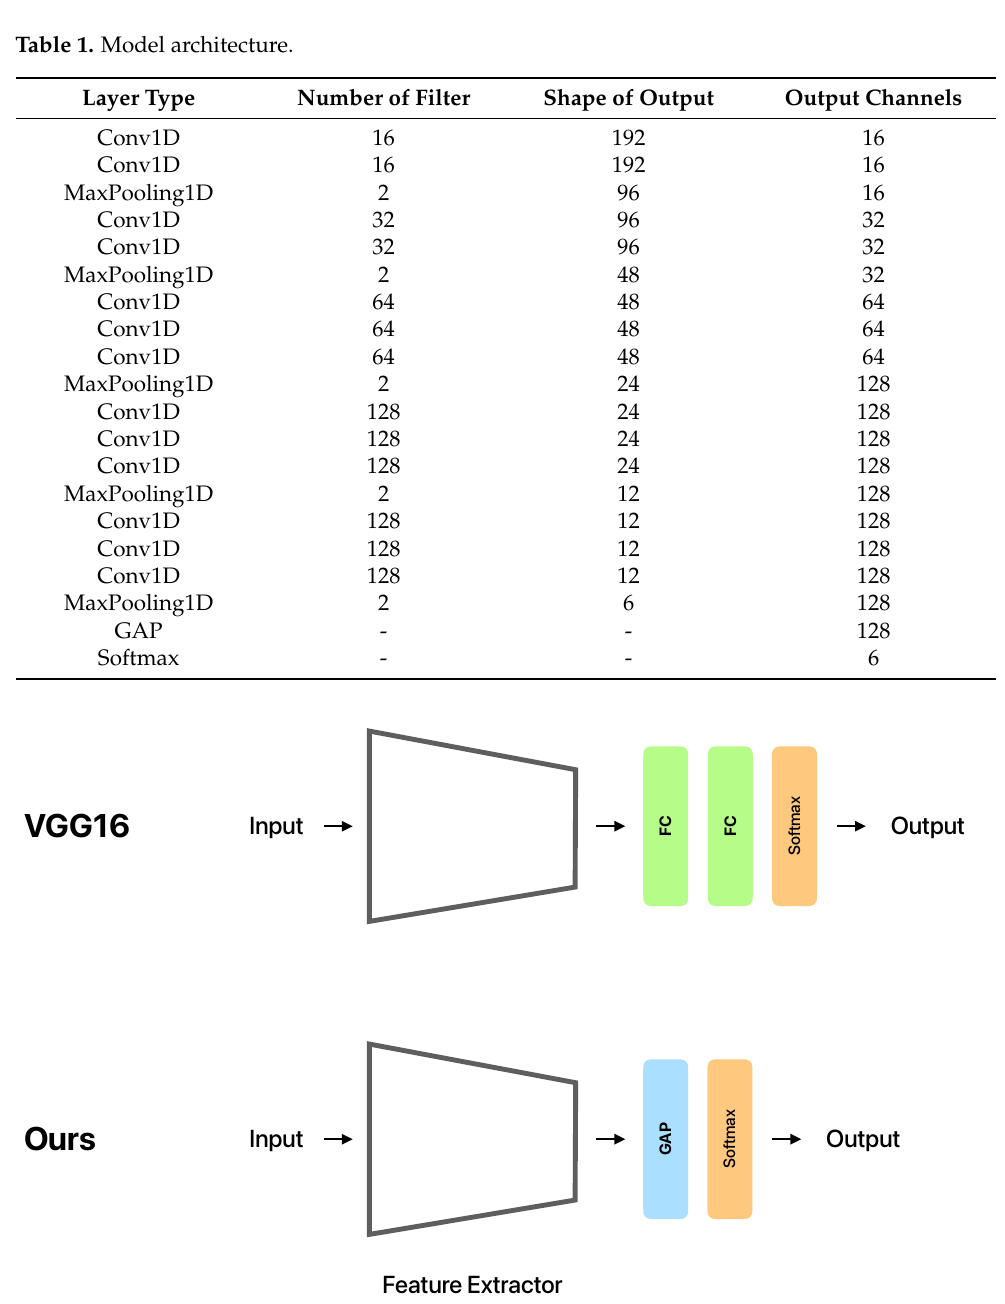
Figure 2. Overview of the original VGG16 and the model used in this study (Ours). The Feature Extractor denotes the part of the architecture shown in Table 1, from the first Conv1D with the 16 filters to the MaxPooling1D before the GAP. FC indicates the fully-connected layer. GAP indicates the global average pooling layer. Softmax is the output layer with softmax activation